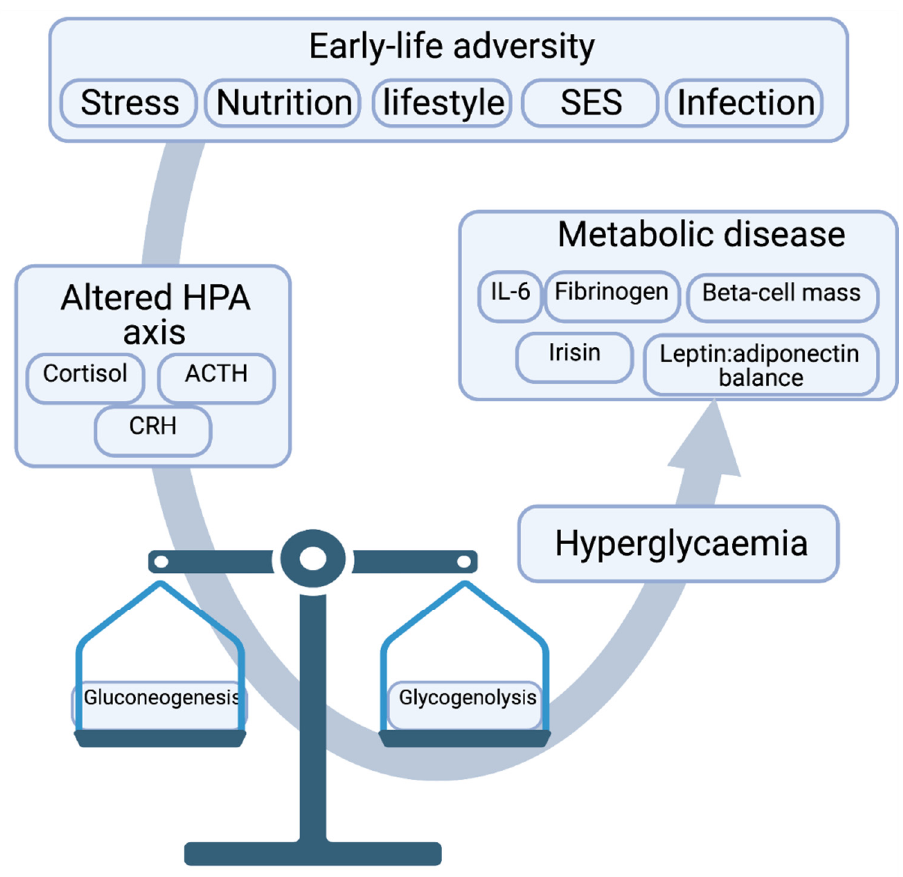
Figure 3. Early life adversity dysregulates the HPA axis and its key effector molecules, which in turn disrupts glucose homeostatic balance, leading to hyperglycaemia and metabolic syndrome if left